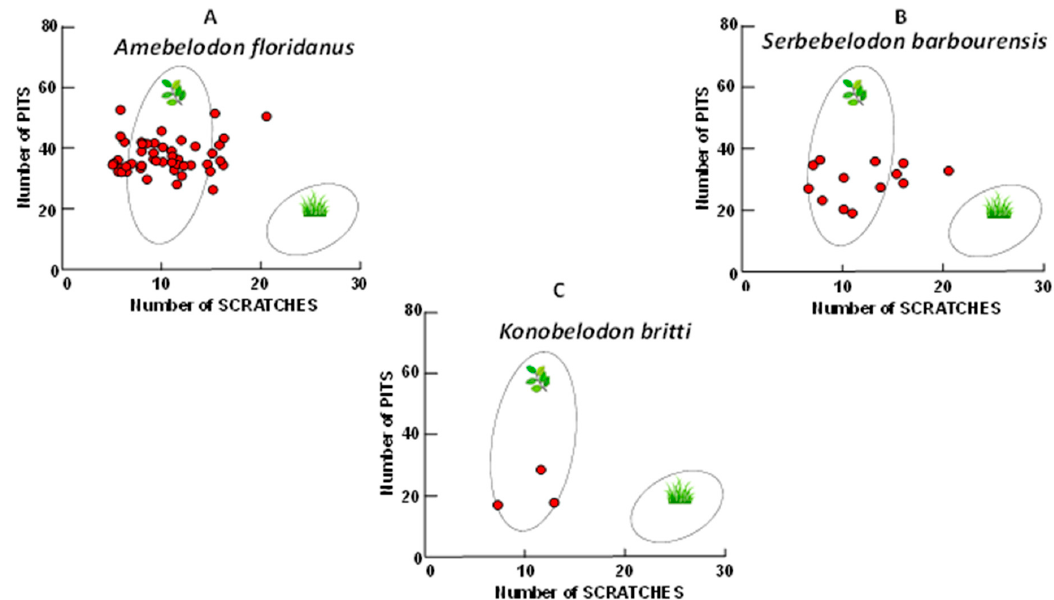
Figure 4. Fossil shovel-tusker raw scratch bivariate plots. Individual raw scratch and pit results of fossil shovel-tuskers compared to extant ungulate scratch/pit microwear ecospaces. ( A ). Amebelodon floridanus raw scratch/pit results. ( B ). Serbelodon barbourensis raw scratch/pit results; ( C ). Konobelodon britti raw scratch/pit results. Gaussian confidence ellipses ( p = 0.95) on the centroid are indicated for the extant browsers on the left and grazers on the right (convex hulls) adjusted by sample size.